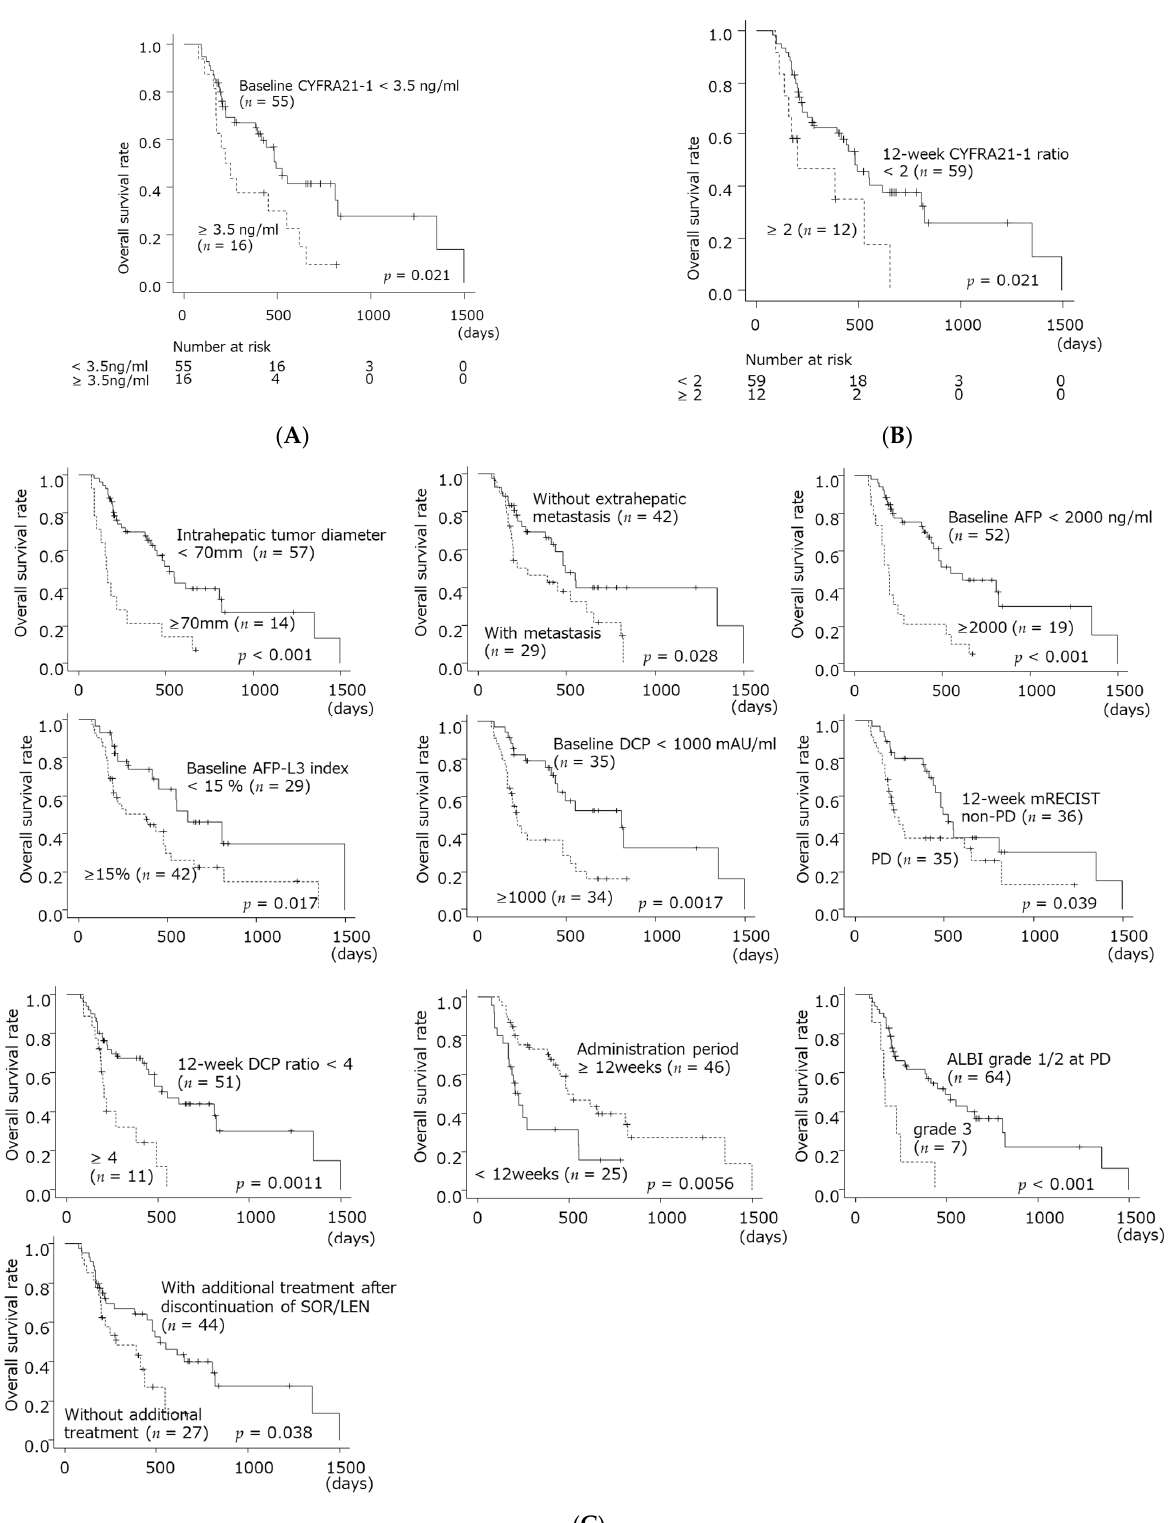
Figure 3. Overall survival after starting SOR/LEN according to baseline CYFRA21-1 level ( A ), 12-week CYFRA21-1 ratio ( B ), and other prognostic factors ( C